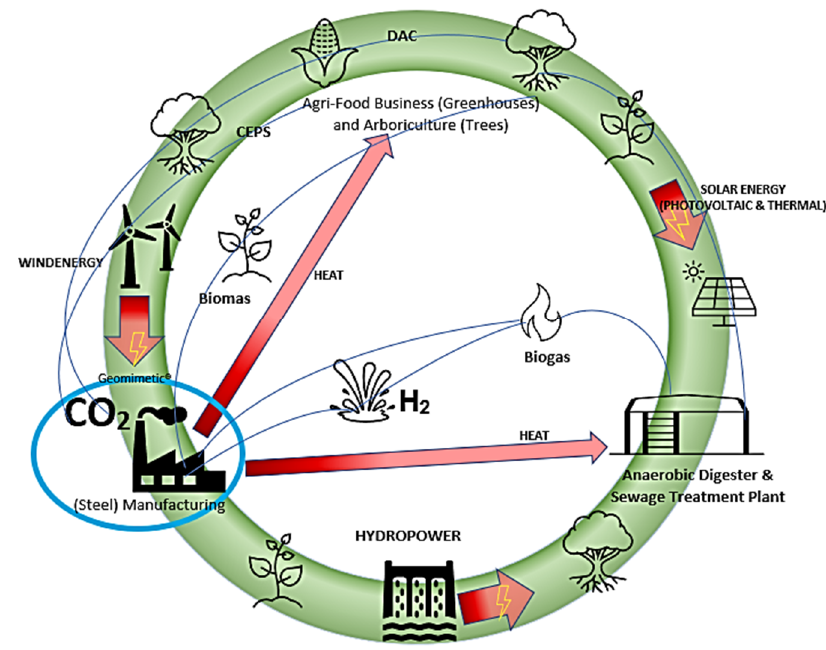
Figure 2. The Bio Steel Cycle concept and cyclical resource utilisation flow.